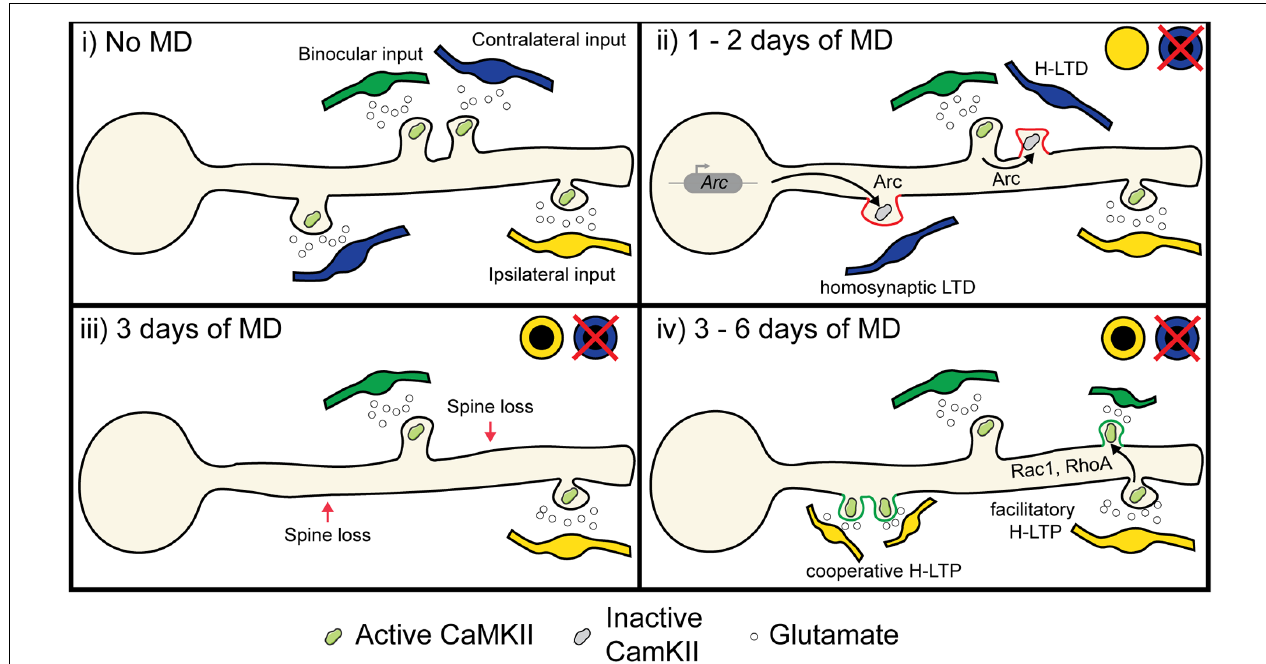
FIGURE 5 | Proposed role of heterosynaptic plasticity in ODP. (i) During normal vision, monocular inputs from the contralateral and ipsilateral eye, as well as binocular inputs, converge onto neurons in the binocular visual cortex. Some visual inputs cluster for similar receptive field preferences and orientation preferences (Iacaruso et al., 2017; Lee et al., 2019). (ii) At 1 or 2 days of MD, low or unpatterned drive from deprived eye inputs lowers CaMKII activity in spines, which causes some spines to undergo homosynaptic LTD due to cell-wide transcription of Arc (McCurry et al., 2010), which binds with inactive CaMKII to induce AMPA receptor endocytosis (Okuno et al., 2012). Heterosynaptic LTD occurs in deprived eye inputs that are functionally clustered with open eye inputs due to the local translation and translocation of Arc (El-Boustani et al., 2018). (iii) At 3 days of MD, synapses exhibiting LTD are decreased in size or lost (Sun et al., 2019). (iv) After 6 days of MD, heterosynaptic potentiation occurs following spine loss (Frank et al., 2018). Existing open eye inputs facilitate the formation and strengthening of neighboring open eye synapses through the diffusion of activated GTPases such as Rac1 and RhoA (Hedrick et al., 2016). Furthermore, new clusters of open eye synapses also form through cooperative plasticity (Lee et al., 2016). Image assets reproduced from smart.servier.com (Servier Medical Art, 2015) (CC-BY).